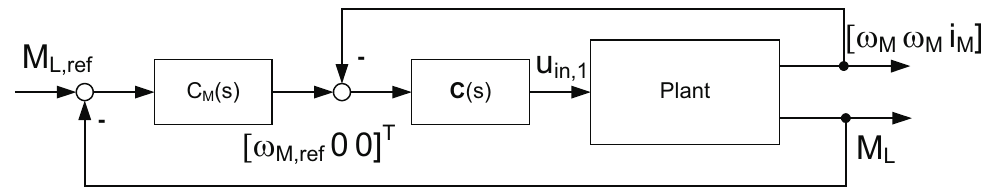
Figure 4. Block diagram of the classical cascaded controller structure (the inner current control-loop is not shown and assumed to be